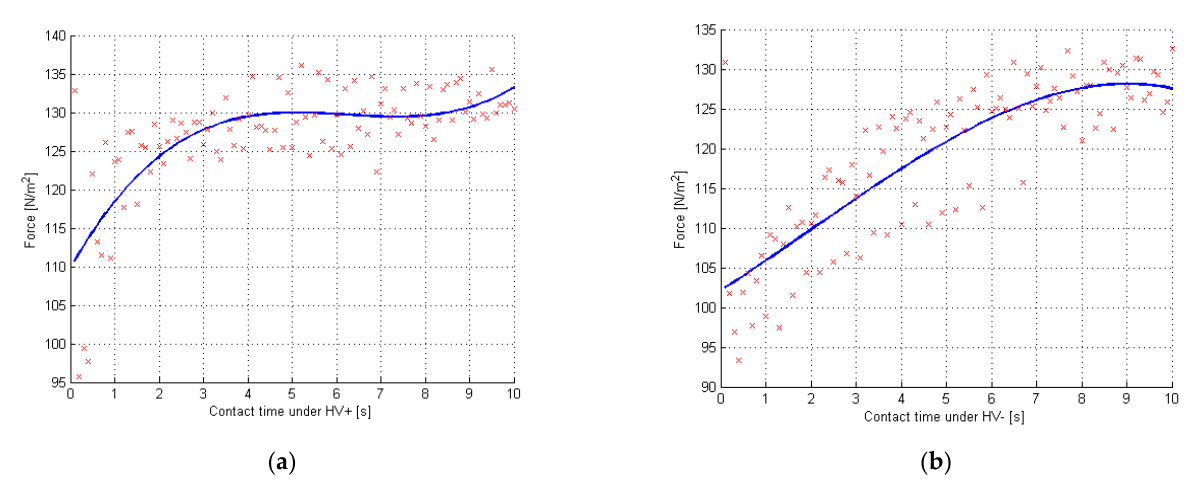
Figure 6. Charts representing the dependence of the electroadhesive force on the given polarization ( a ) HV+ and ( b ) HV − .